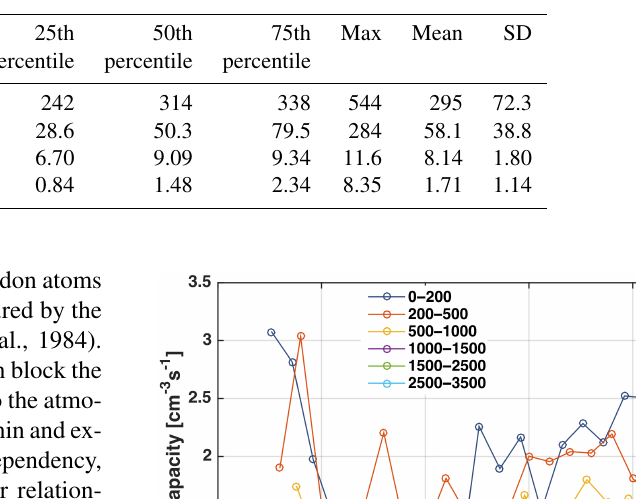
Table 3. Energy in eVm − 3 s − 1 deposited in the air by total environmental gamma radiation ( Eγ ) and by alpha and beta activities from 222 Rn decay ( E Rn) based on the 2003–2006 data. The gamma and radon ionising capacities ( Qγ and Q the deposited energy assuming 34eV for the generation of one ion pair in the air. The statistical features of these data are presented by the five-number summary with two additional measures, the mean and standard deviation (SD).